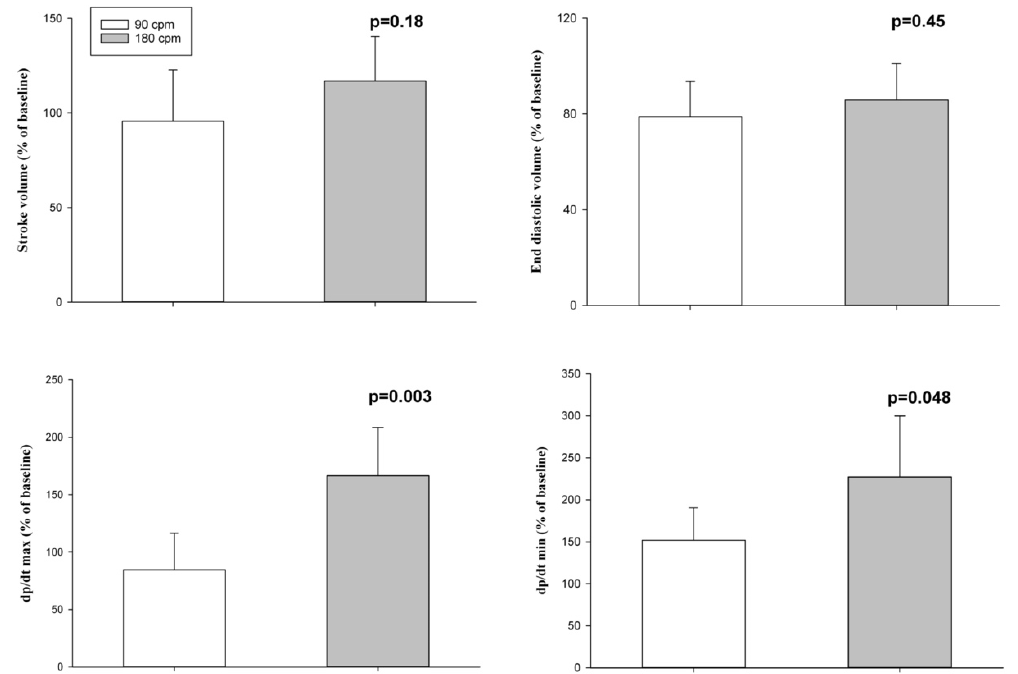
Figure 3. % change from baseline in stroke volume, end-diastolic volume, dp/dt max (maximal rate of rise of left ventricular pressure), and dp/dt min (minimum rate of change of ventricular pressure).